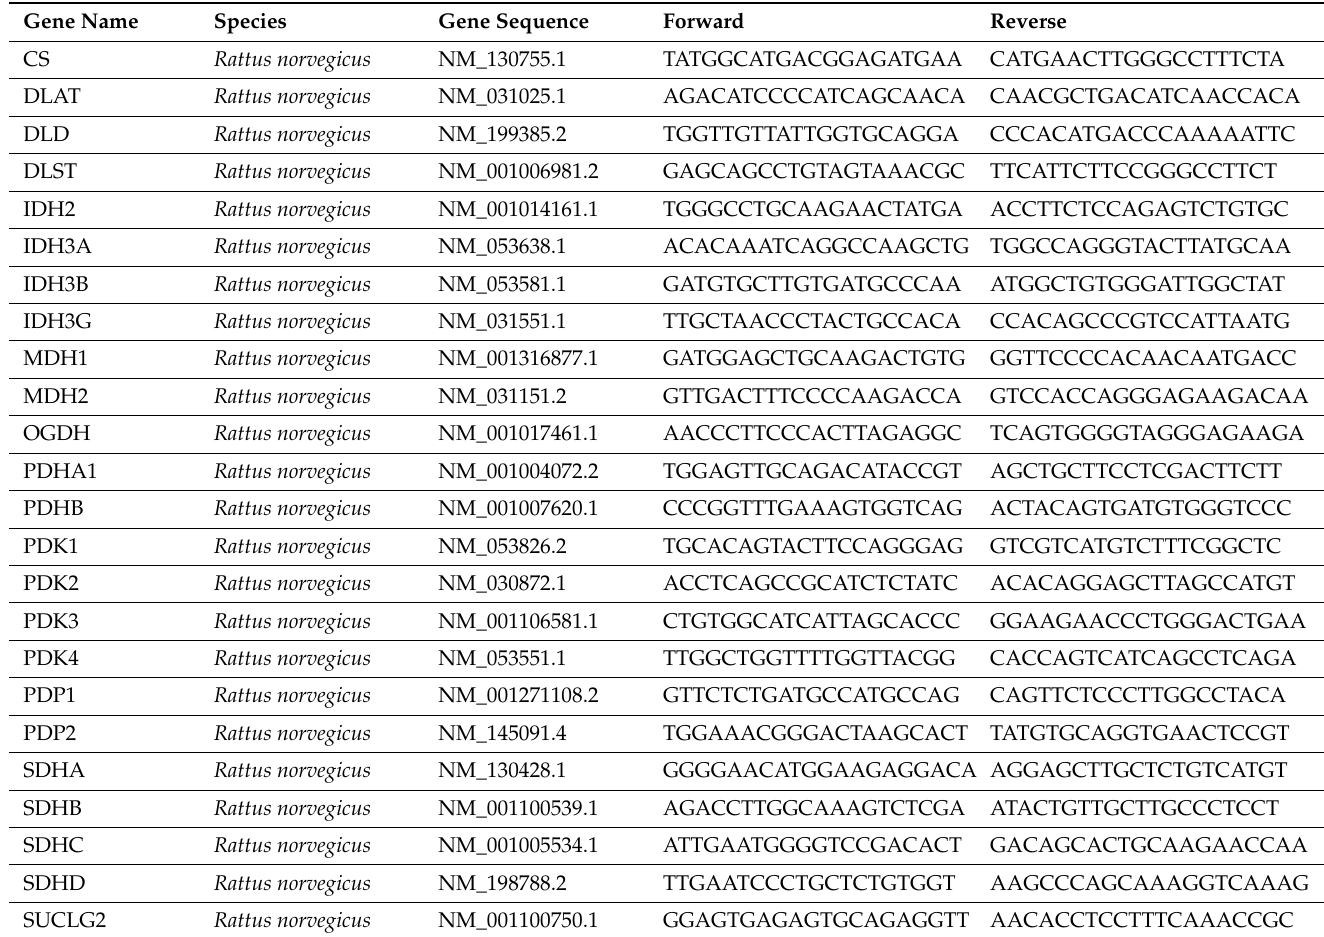
Table 1. Sequences of the primers used to evaluate the gene expressions (using real-time quantitative PCR) of the subunits and isoforms of the TCA cycle enzymes, as well as of the phosphorylating (PDK1-4) and dephosphorylating (PDP1-2) enzymes regulating the activity of the PDH complex in brain tissue homogenates of control and TBI-injured